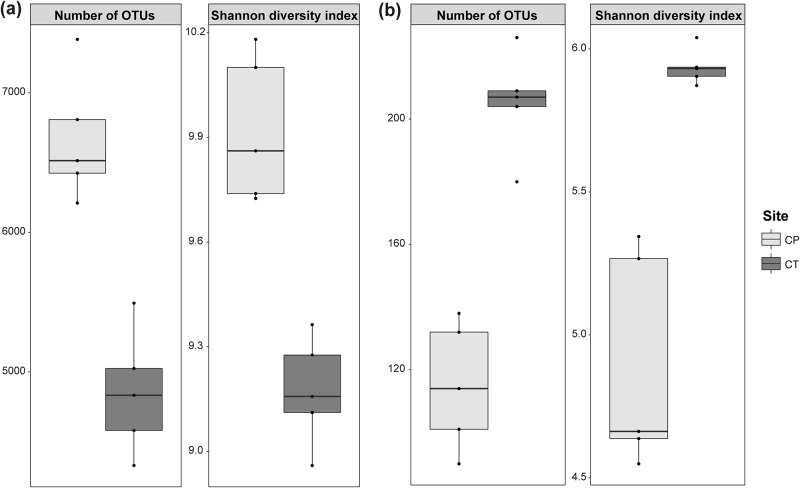
Boxplots of sample richness and diversity at a genetic distance of 3% in Chionochloa pallens and Chionochloa teretifolia grassland soils based on (a) 16S rRNA and (b) nifH gene sequences.Number of unique OTUs and Shannon diversity indices were calculated at 97% similarity for 198 769 and 9658 subsampled 16S rRNA and nifH gene sequences, respectively.